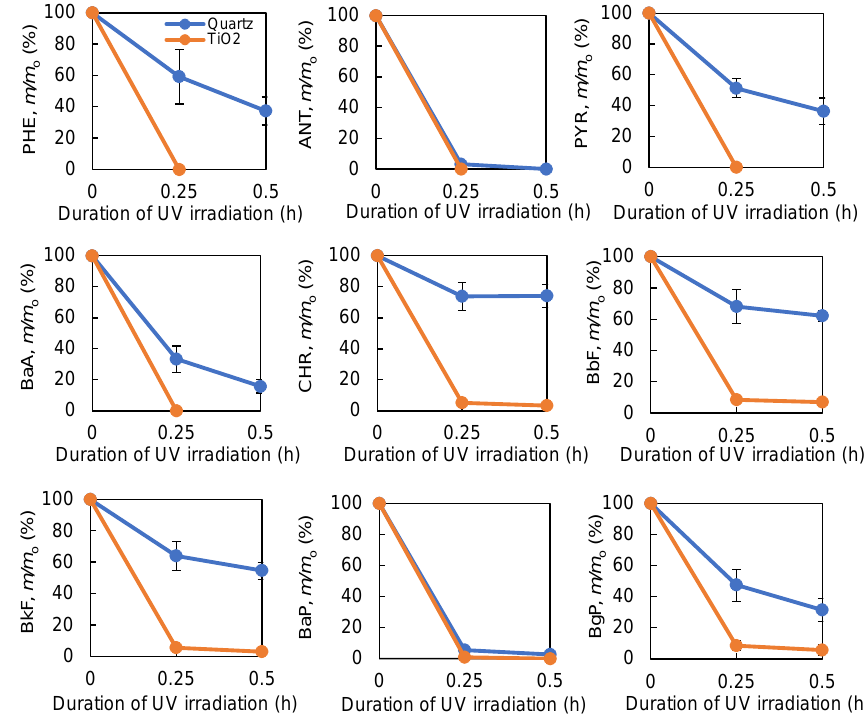
Figure 5. UV-induced degradation of PAHs in direct contact with quartz filters and TiO 2 filters following addition of a PAH solution. Plots are the average of three samples and the error bars show the standard deviations.